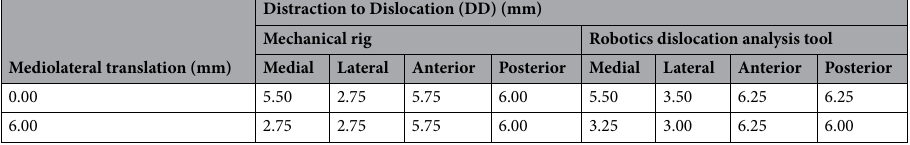
Table 1. Dislocation results obtained using the mechanical rig versus the robotics dislocation analysis tool.